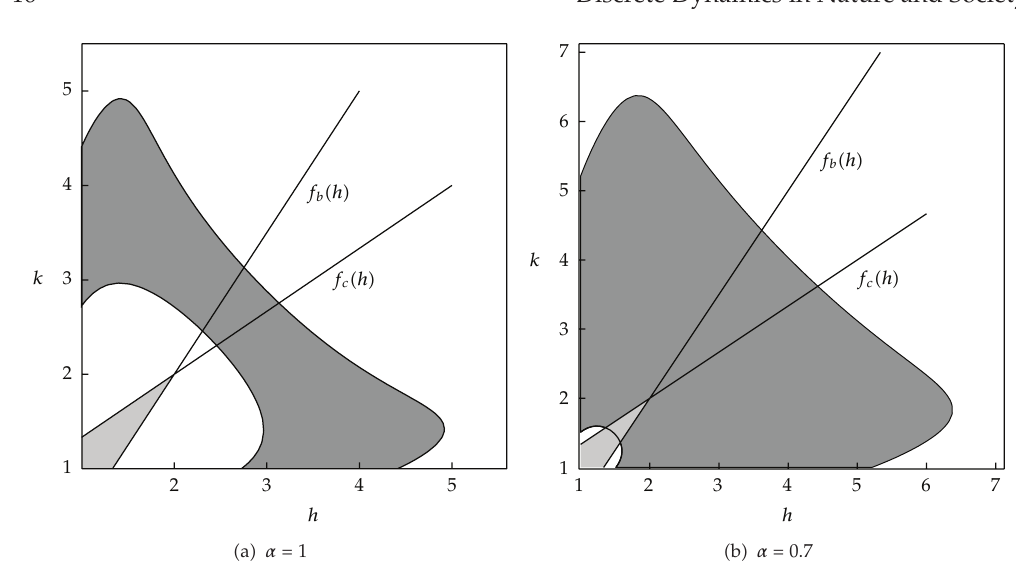
Figure 3: Stability and feasible regions of the naive and adaptive systems.